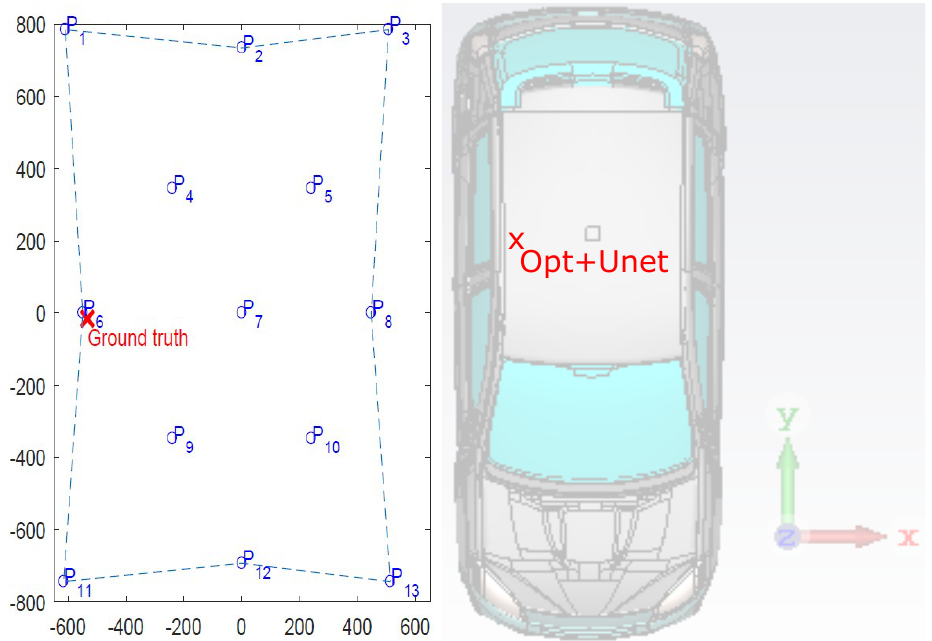
Figure 9. Ground truth is in position 6. F has the maximum value for all 13 training points, and the Bayesian optimization + U-Net solution found is near this